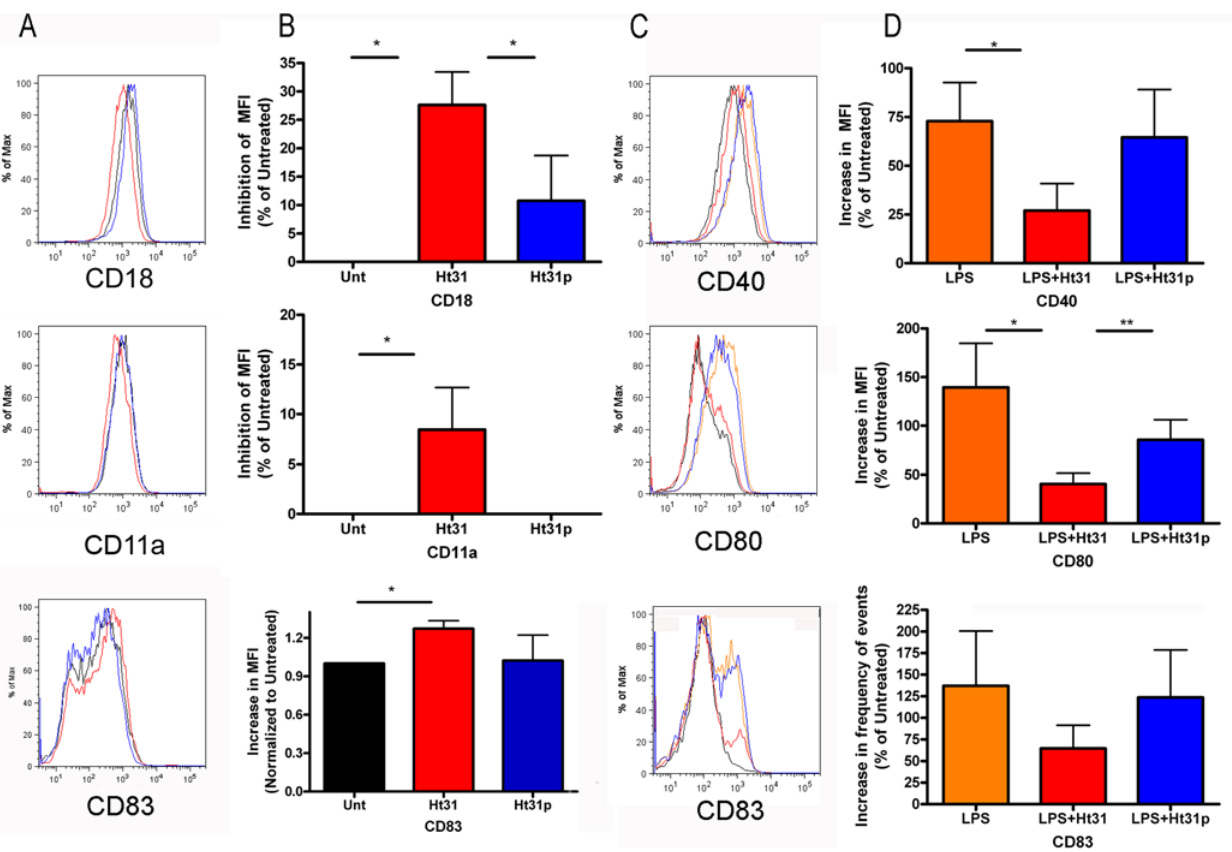
Figure 8. Ht31 inhibits cell surface expression of CD18, CD40, CD80 and CD83. Day 5 DC were incubated without or with 10 ng/ml LPS and 100 m M Ht31 or Ht31p for 48 hours. Cells were collected, blocked, and stained for cell surface expression using conjugated antibodies, see materials and methods. FACS analysis was performed on a LSRII using FacsDiva software. A) One representative histogram showing untreated cells (black trace), Ht31 treated cells (red trace), and Ht31p treated cells (blue trace). B) Graphical representation of percent inhibition of mean fluorescent intensities compared to untreated samples, data from eight donors was normalized and averaged. C) One representative histogram showing untreated cells (black trace), LPS treated cells (orange trace), LPS + Ht31 (red trace), and LPS + Ht31p (blue trace). D) Graphical representation of percent increase in mean fluorescent intensity compared to untreated cells, data from five donors was normalized and averaged. Error bars are S.E.M. Student ttest yielded statistical significance as indicated, P , 0.05 (*), P , 0.1